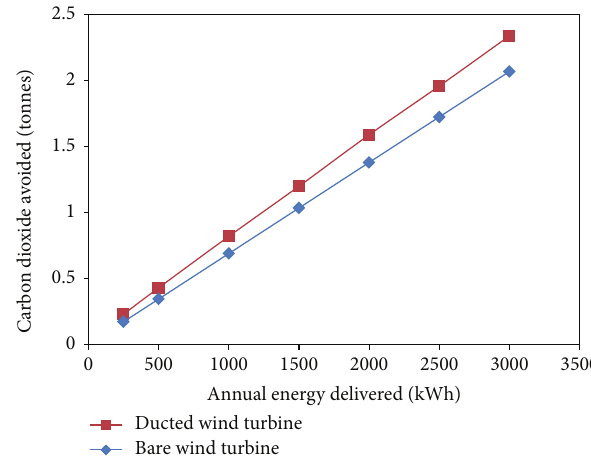
Figure 4: Annual carbon dioxide avoided from the DSWES and SWES for varying annual energy